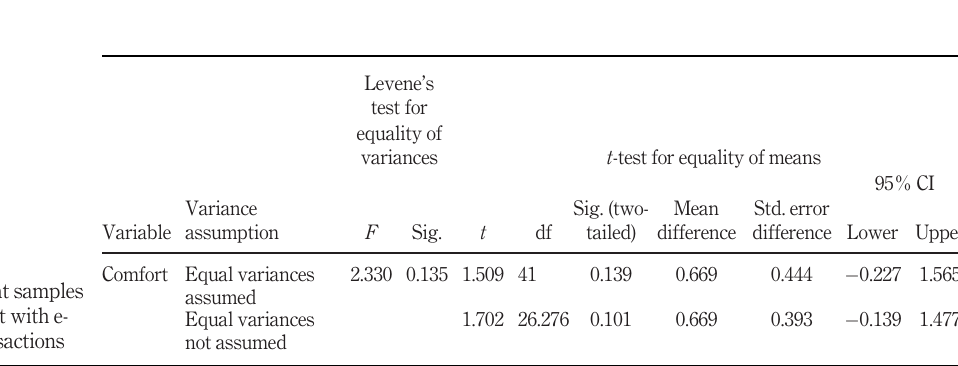
Table 7. Independent samples test-comfort with e- wallet transactions